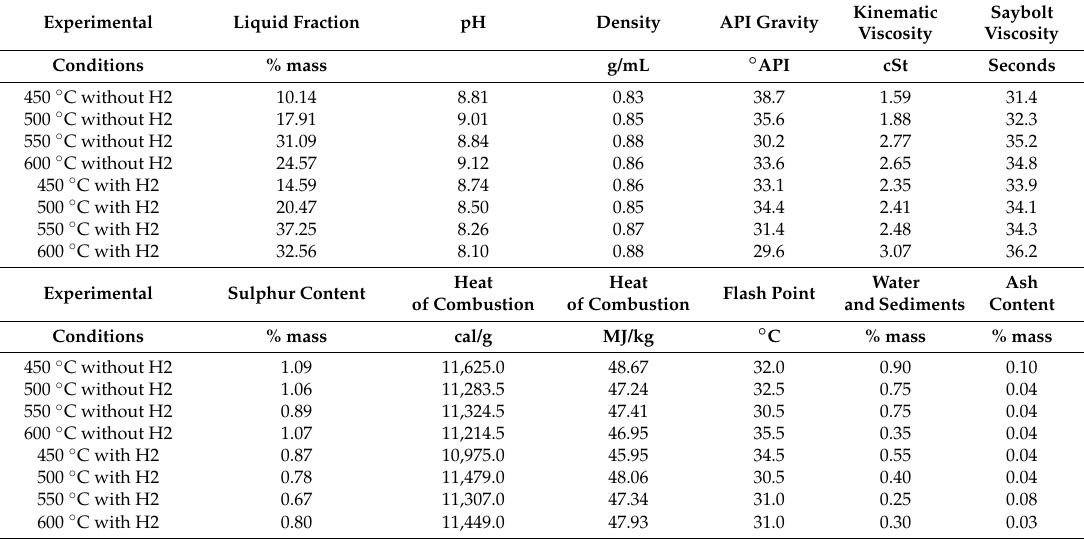
Table 3. Geometrical average values that resulted from the physicochemical characterization of the pyrolysis liquid